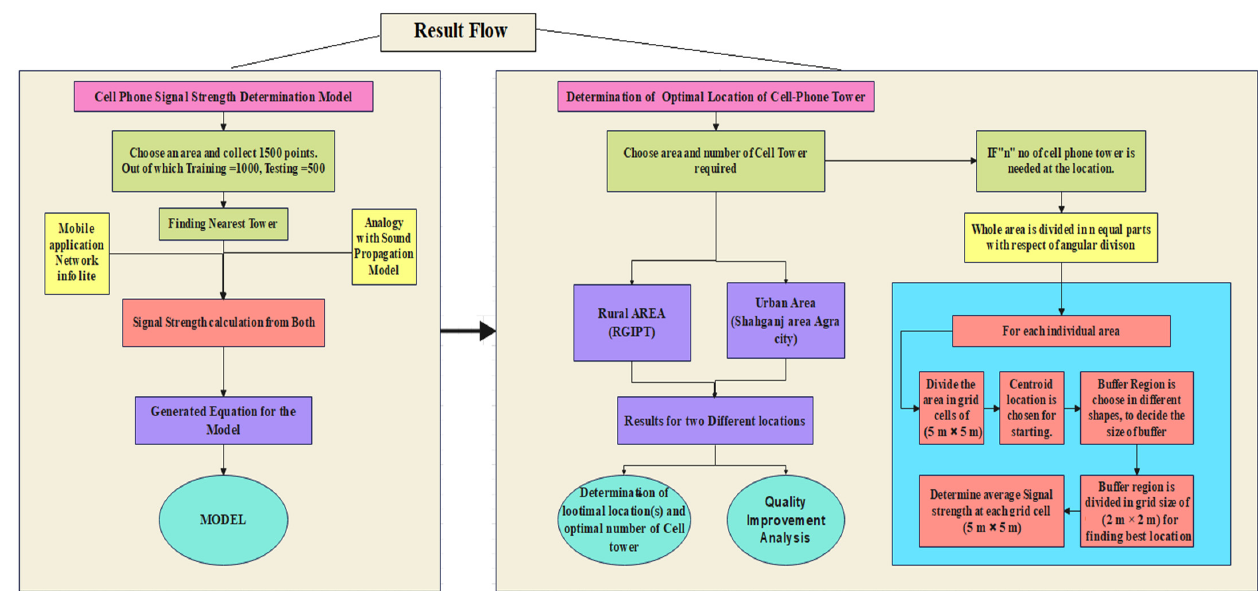
Figure 7. Result Flowchart.